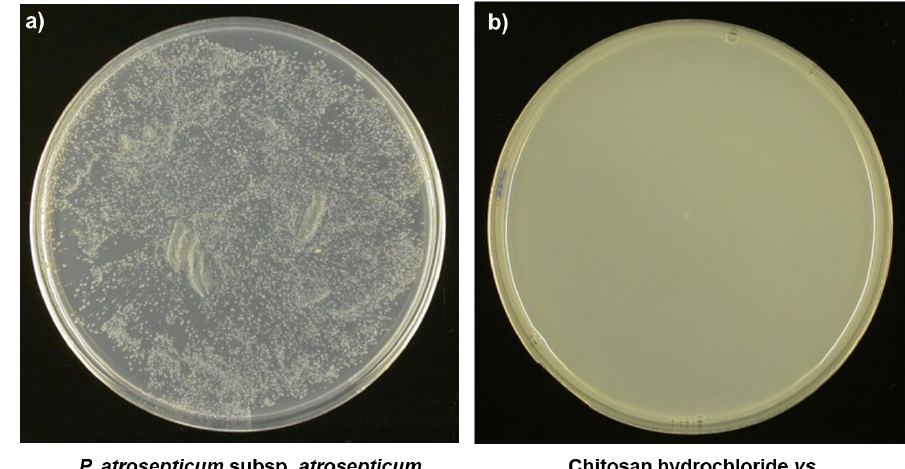
Figure 7. In vitro growth of colonies of Pectobacterium carotovorum subsp. carotovorum ( a ) in NA medium (control) or ( b ) in NA amended with CH ( p = 0.01).